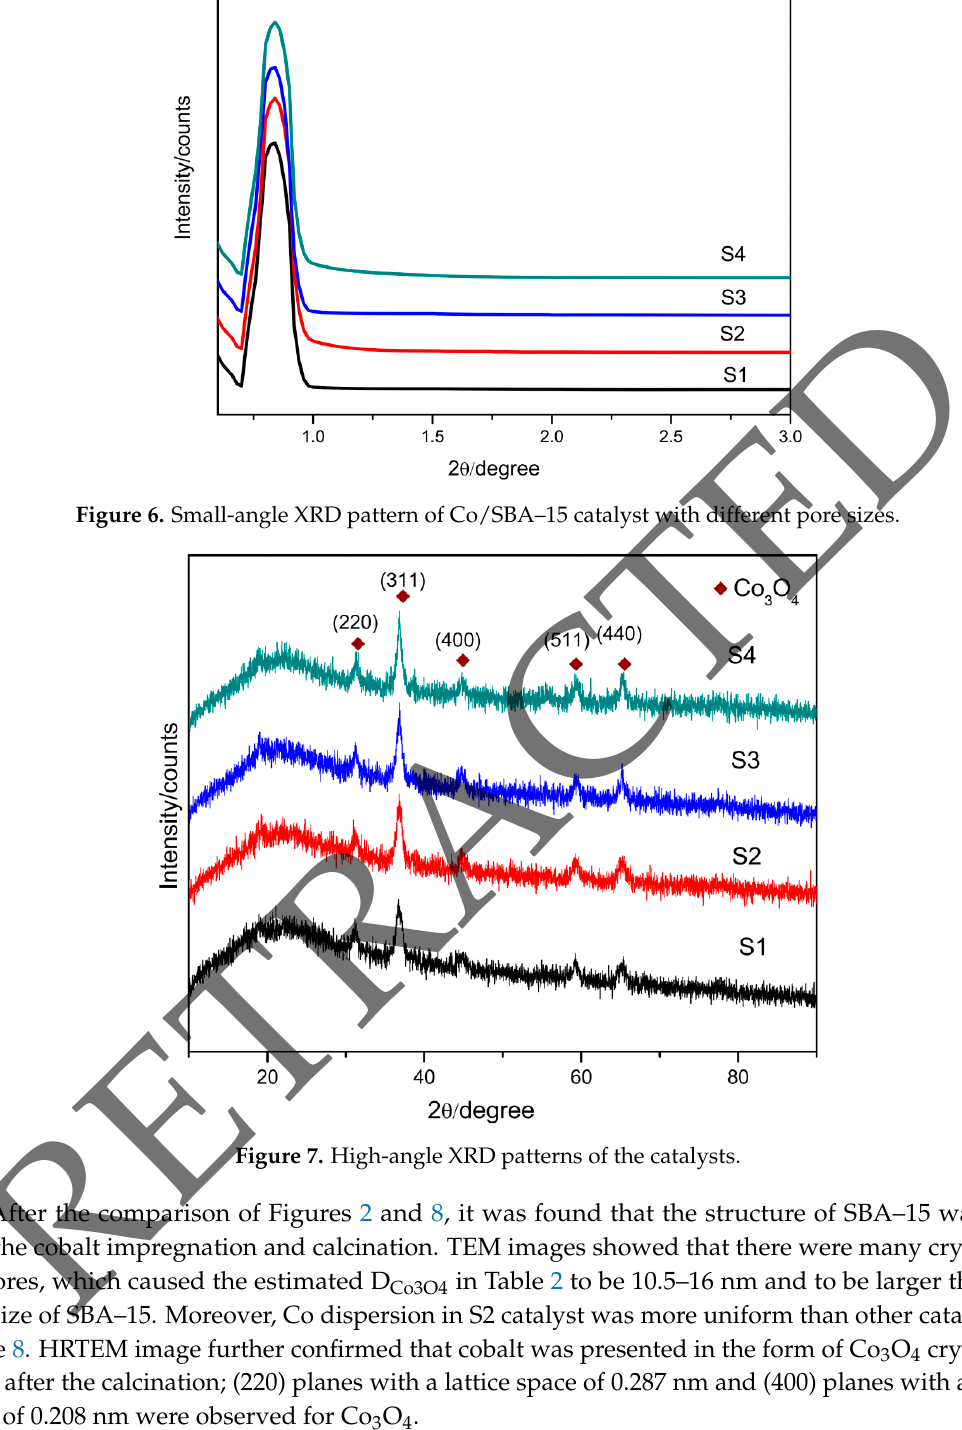
Figure 7. High-angle XRD patterns of the catalysts.